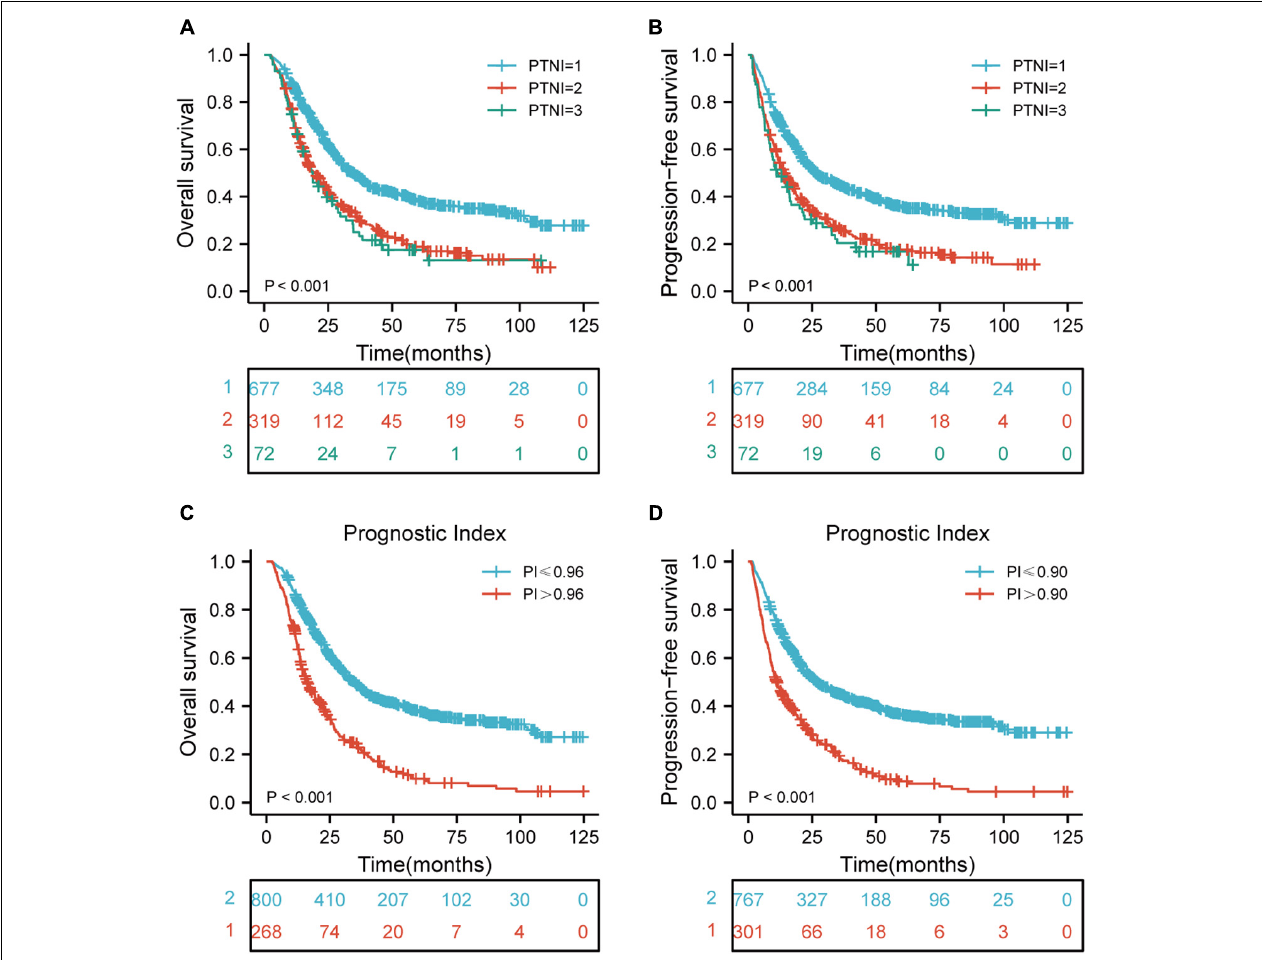
FIGURE 3 | Risk stratification for PTNI and PI on OS and PFS according to risk groups. (A) Risk stratification for PTNI on OS ( p < 0.001); (B) risk stratification for PTNI on PFS ( p < 0.001); (C) risk stratification for PI on OS ( p < 0.001); (D) risk stratification for PI on PFS ( p < 0.001); OS, overall survival; PFS, progression-free survival; PTNI, pre-therapeutic nutritional index; PI, prognostic